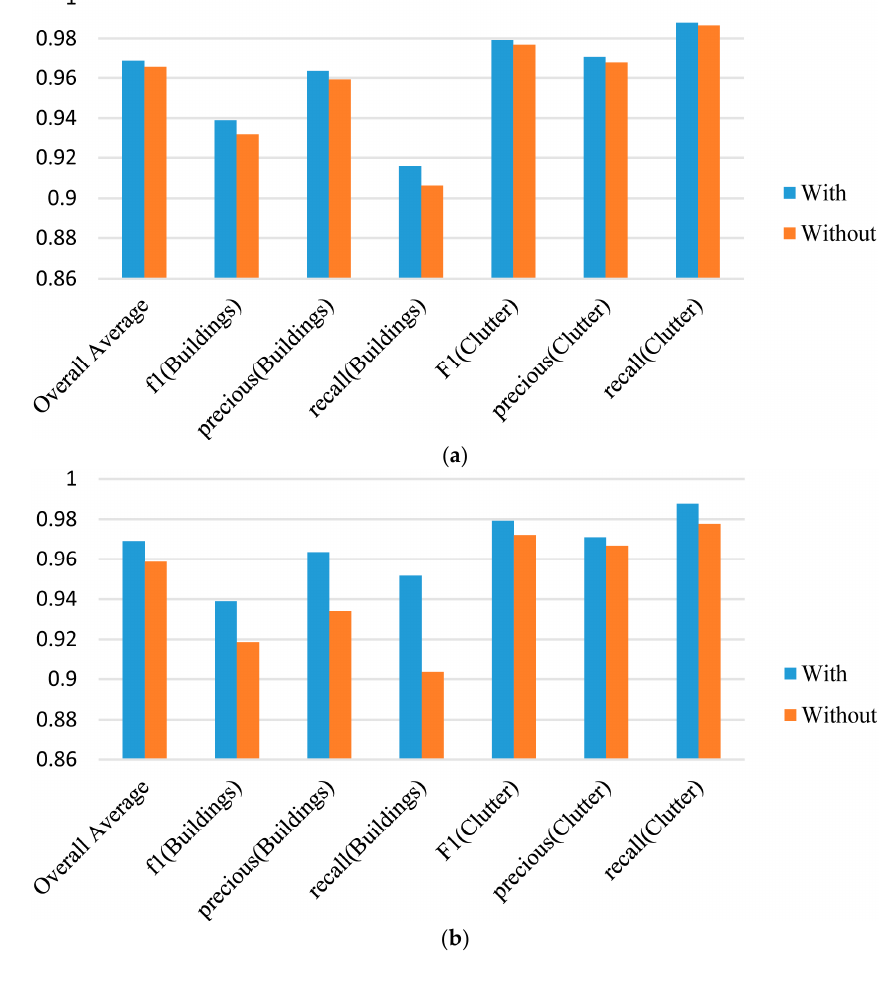
Figure 7. The results of the building extraction from the urban districts of the Potsdam ( a ) and Vaihingen ( b ) datasets with and without edge enhancing in the preprocessing stage.